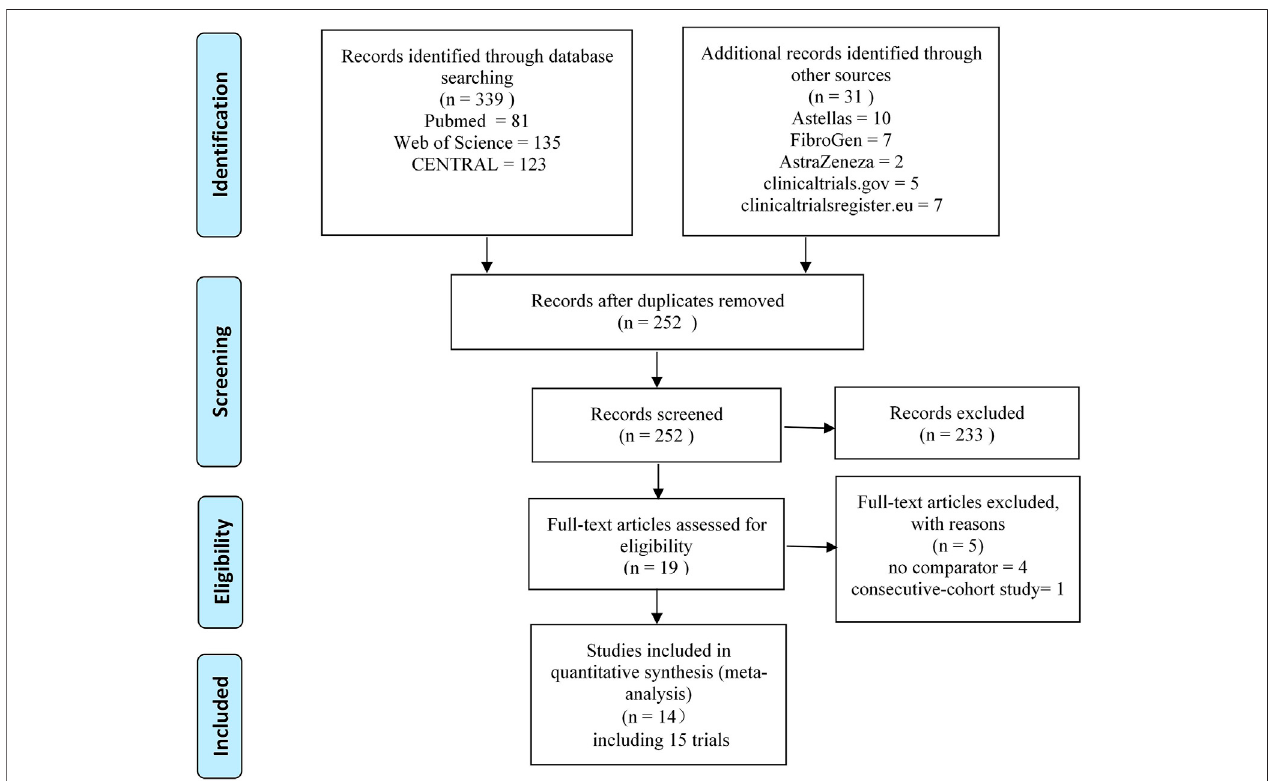
FIGURE 1 | PRISMA fl ow diagram of eligible